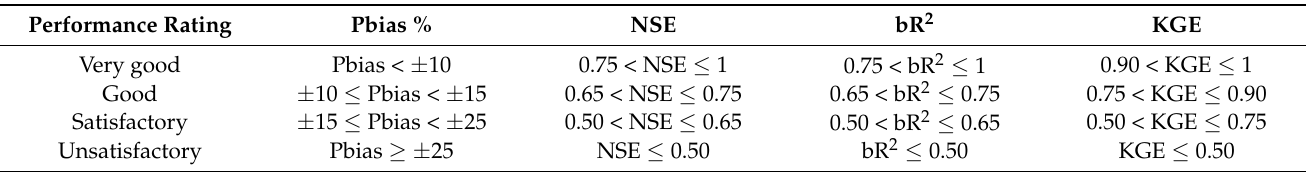
Table 1. Goodness-of-fit indicators for evaluating the performance of hydrological models for streamflow (adapted from Moriasi et al. [74,75]).